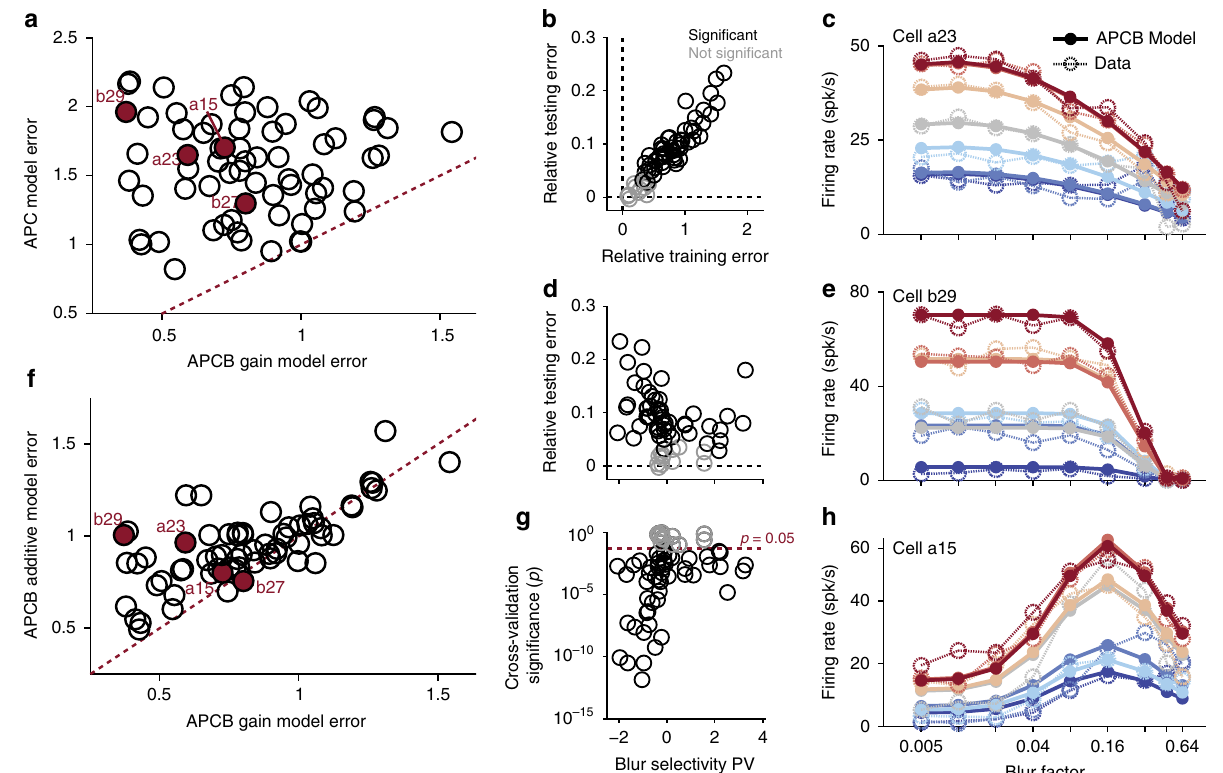
Fig. 7 Responses explained by a joint model of shape and blur. a NRMS fi t error of an APC model plotted as a function of NRMS fi t error of an APCB model for each neuron. Example cells are fi lled and labeled. b , d , g Even though the APCB is a generalization of the APC model, i.e., APCB models form a superset of APC models with two additional parameters, cross-validation demonstrates the APCB model to better predict responses to blurred stimuli: b Average NRMSE across training and testing stimuli reveals the APCB model to better predict responses without over fi tting; relative error, computed as APC — APCB error, is positive in all signi fi cant cases ( g ). d Relative testing NRMSE between models, plotted as a function of blur selectivity PV, demonstrates the APCB model to better predict responses over a range of neuron tuning pro fi les. g Signi fi cant (black) and not signi fi cant (gray) cases of prediction improvement were determined with a pair-wise t -test across hold-out validation stimuli (see Methods: ‘ Analysis and model fi tting ’ ). c , e , h Observed responses (open circles, dashed lines) and APCB model fi ts ( fi lled circles, solid lines) for three example neurons (Fig. 2a, c, d). Qualitative assessment of fi ts suggests that the APCB model captures blur-tuned response properties remarkably well. f Comparison of the APCB gain model against an APCB additive variant with equal degrees of freedom (see Methods: ‘ Analysis and model fi tting ’ ). Most neurons are better fi t by the APCB gain model, particularly when error is small, consistent with blur selectivity being explained by gain